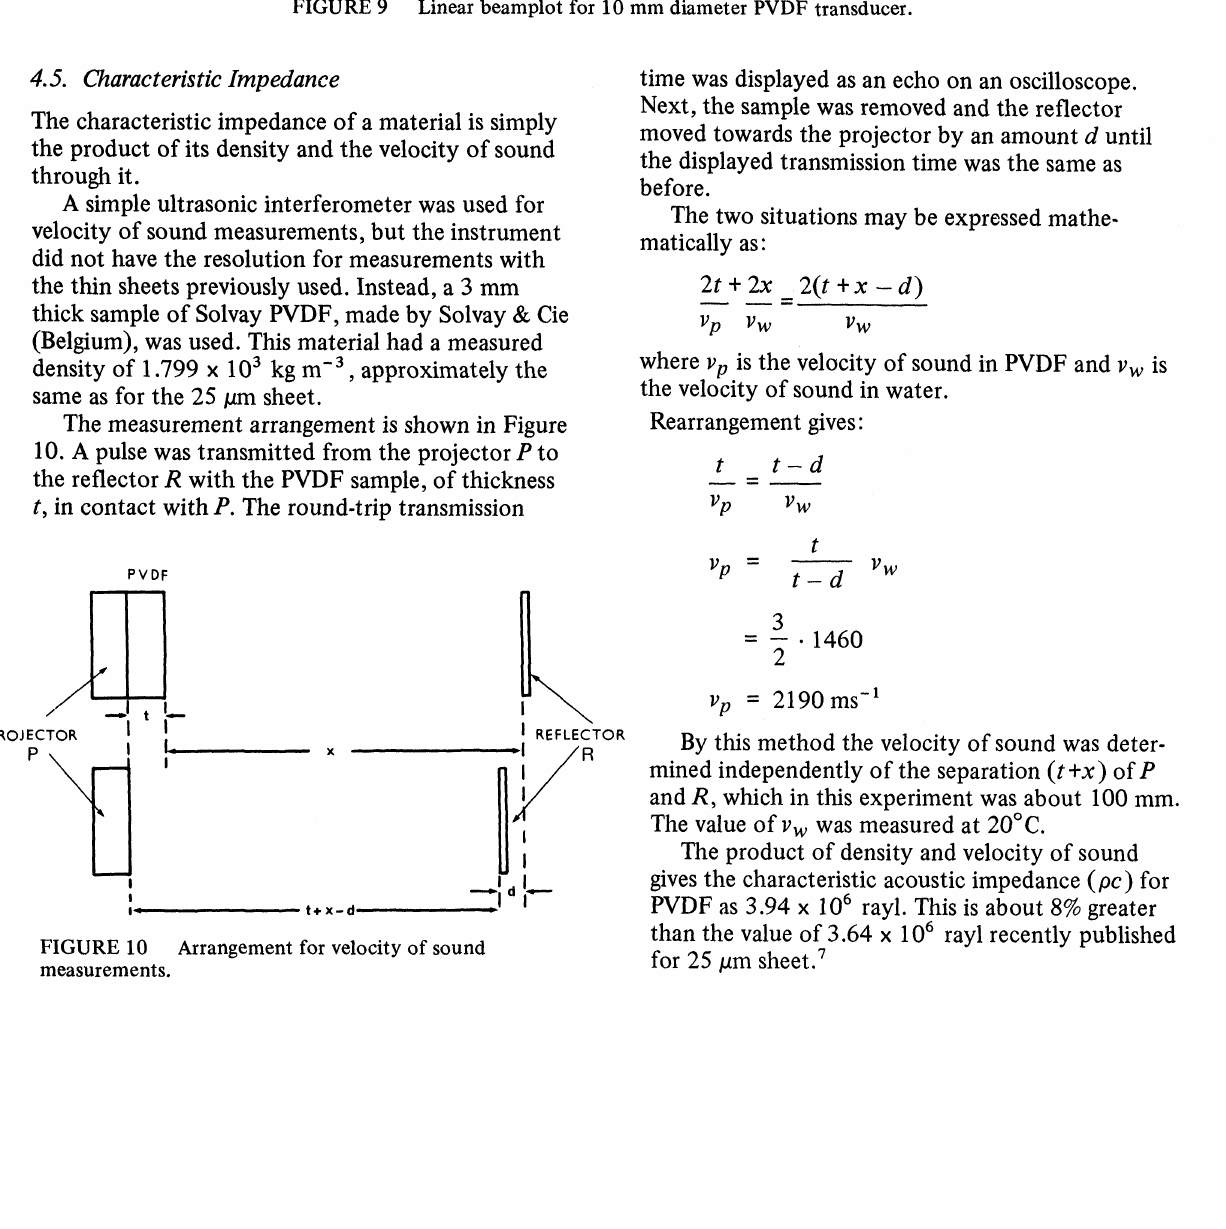
FIGURE 9 Linear beamplot for 10 mm diameter PVDF transducer.